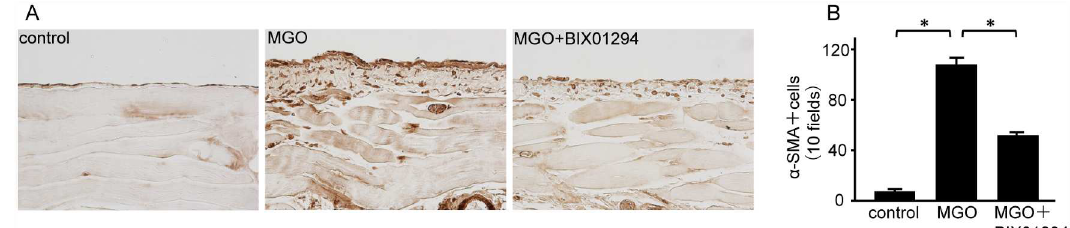
Fig 3. BIX01294attenuates α -Smooth Muscle Actin ( α -SMA) expressionin mice with peritoneal fibrosis. (A) Immunohistochemicalstaining shows typical α -SMA expressionin peritonealtissue of control mice, MGO-injected mice, and MGO-injected mice treated with BIX01294(originalmagnification, × 200). (B) Graph indicatesthe numberof α -SMA- positive cells in the three groups of mice. Data are expressedas the mean ± SE. Statistical analysiswas performed by analysisof variancefollowedby Tukey’s post-hoc test. * P < 0.05, n = 5 mice per group.